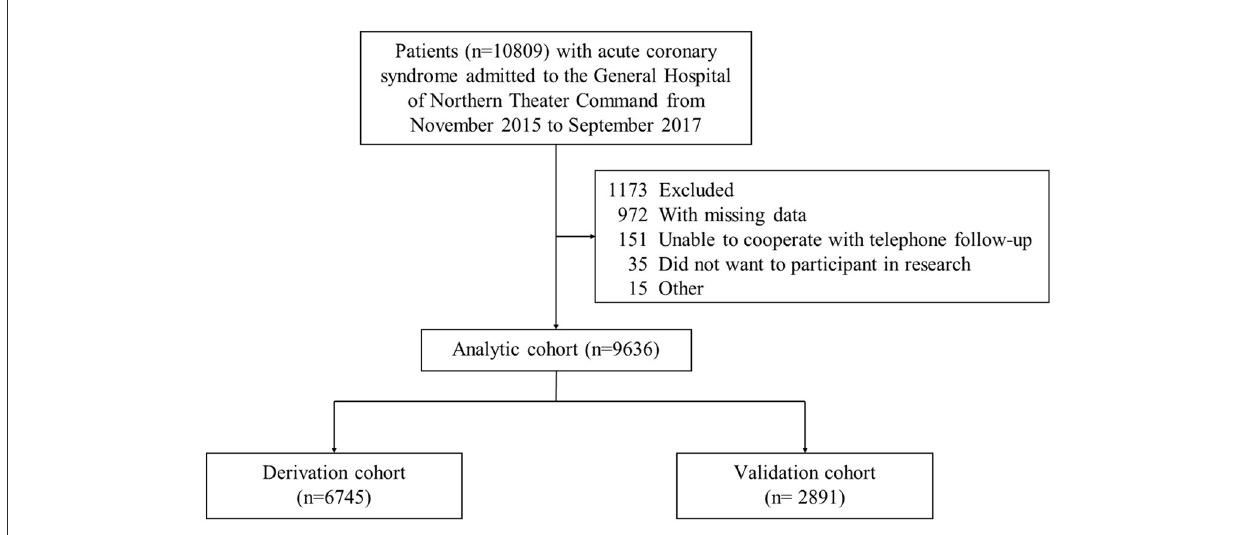
FIGURE1 Study flow diagram.